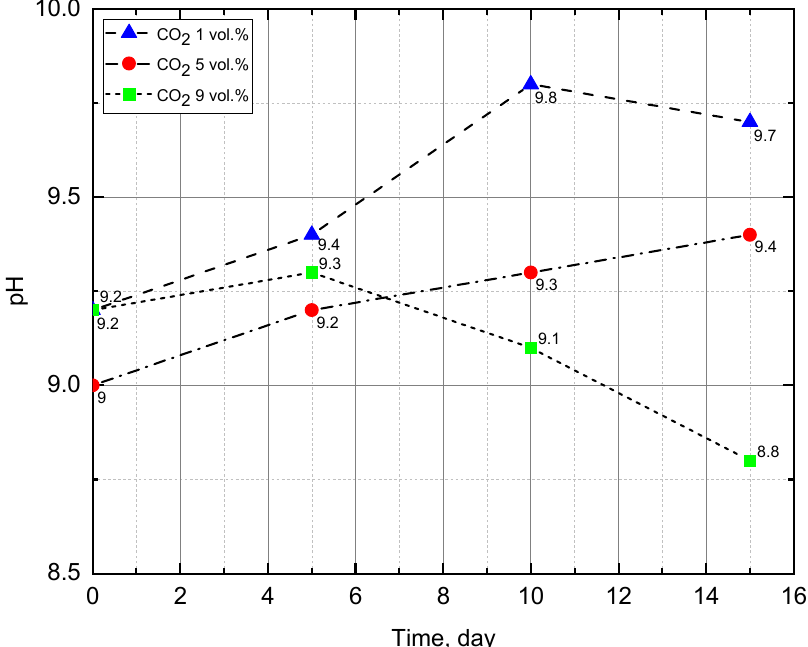
Figure 4. Change of pH during the experiments.